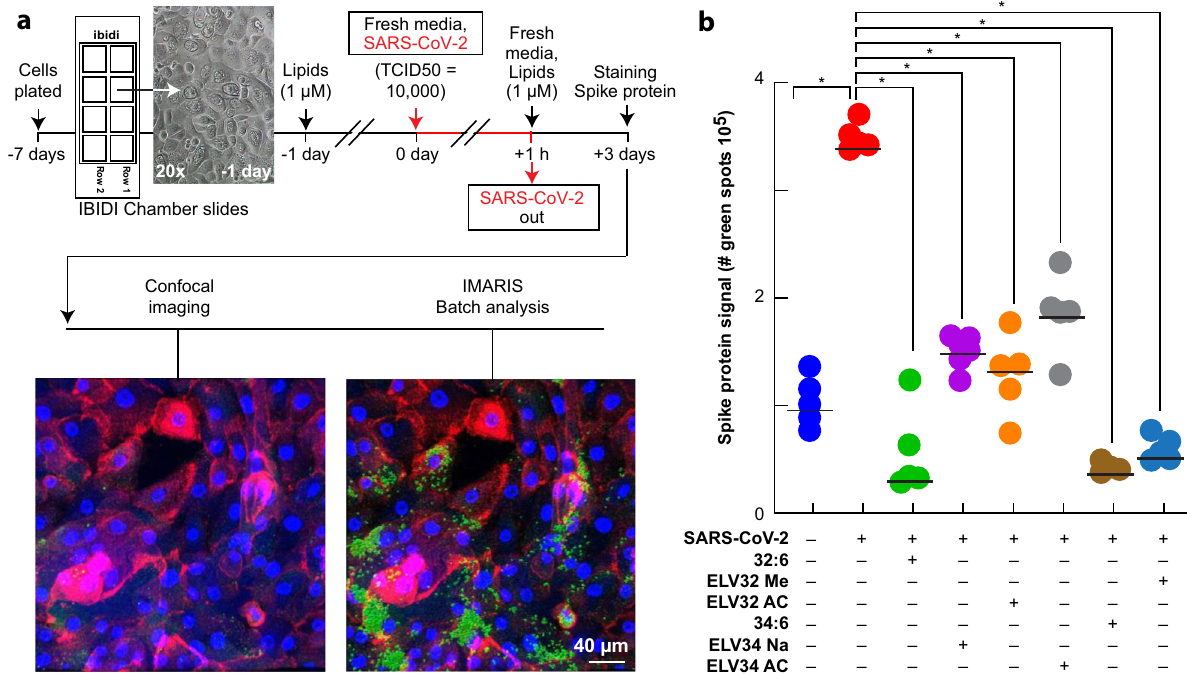
Figure 3. Addition of VLC-PUFAs (C32:6 and C34:6, 1 μM) or ELV-N32 or ELV-N34 decreased viral infection in human primary alveolar cells. ( a ) Timeline of the treatment and infection of human alveolar cells in culture. The cells were plated and let them seat for 7 days until confluency. The day before infection, cells were pre- incubated with 1 μM of Elovanoid 32 methyl-ester (Elv32 Me), Elovanoid 34 sodium salt (Elv34 Na), Elovanoid 32 Acetylenic (Elv32 AC), Elovanoid 34 Acetylenic (ELV34AC) or their precursors, the very long fatty 32:6 or 34:6. On the day of the infection, the medium was removed, the virus was added in a small volume for an hour and then replaced by fresh medium containing the lipids mentioned before. After 3 days, the cells were fixed and stained, and confocal images were taken. Imaris unbiased Batch analysis was performed. The cells were counterstained for membrane (red) and nucleus (blue) with cell mask and Hoechst. ( b ) The number of spots of green signal corresponding to Spike protein was counted and plotted. The data were plotted and analyzed with Graph pad. Normality and Anova were tested. * P < 0.05 in t-test comparisons with the respective